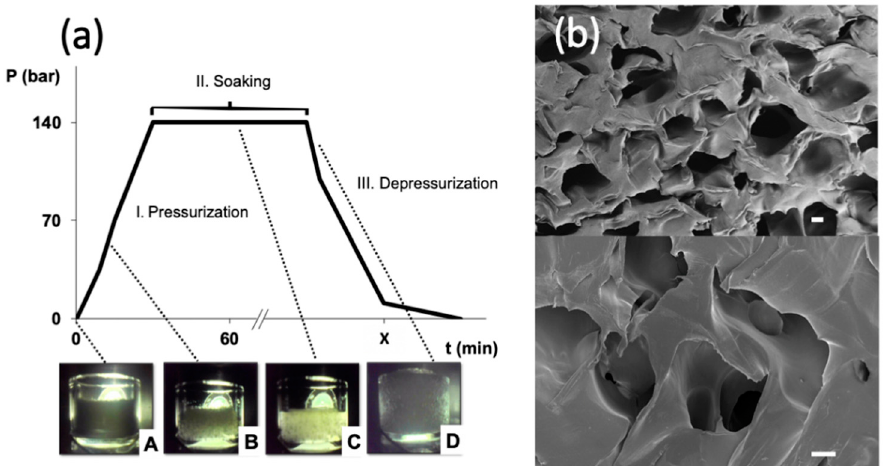
Figure 1. Development of poly( ε -caprolactone) (PCL) scaffolds through the sc-foaming method: ( a ) Typical pressure (P) vs. time (t) profile of sc-foaming tests performed in this work with PCL scaffolds. For certain cases, a visual inspection (pictures at the bottom) of the physical phenomena taking place during the sc-foaming steps (I. pressurization, II. Soaking, and III. depressurization) was carried out: (A) raw PCL powder before CO 2 pressurization, (B) CO 2 solubilization in PCL, (C) polymer melting, and (D) polymeric expansion and formation of pores. ( b ) SEM images of a PCL scaffold processed by sc-foaming at 37 ◦ C and 140 bar with a soaking time of 1 h and slow depressurization (3 bar/min). Scale bars: 100 µ